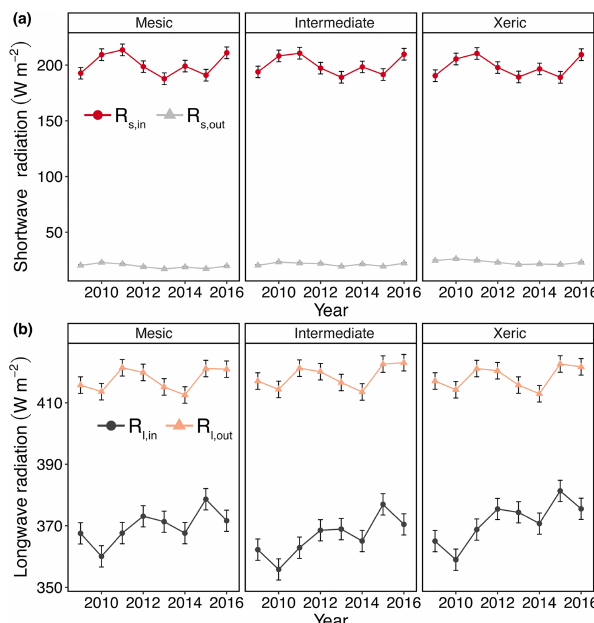
Figure 3. Least squares mean predicted values from mixed mod- els of annual average radiation at the mesic, intermediate and xeric sites for the years 2009–2016: (a) annual incoming and outgoing shortwave radiation ( R s , in and R s , out ) and (b) annual incoming and outgoing longwave radiation ( R l , in and R l , out ). Error bars represent